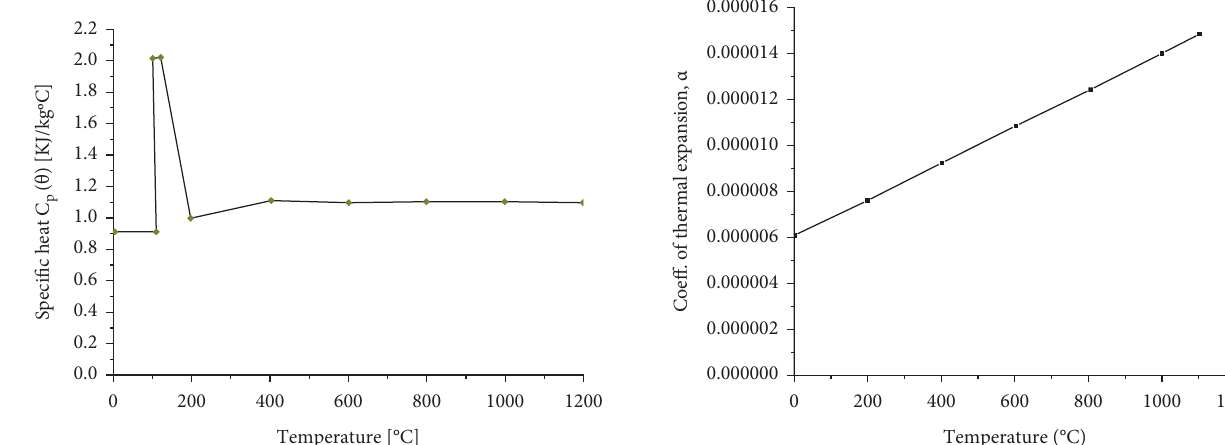
Figure 8: Concrete specifc heat variation with temperature [19].